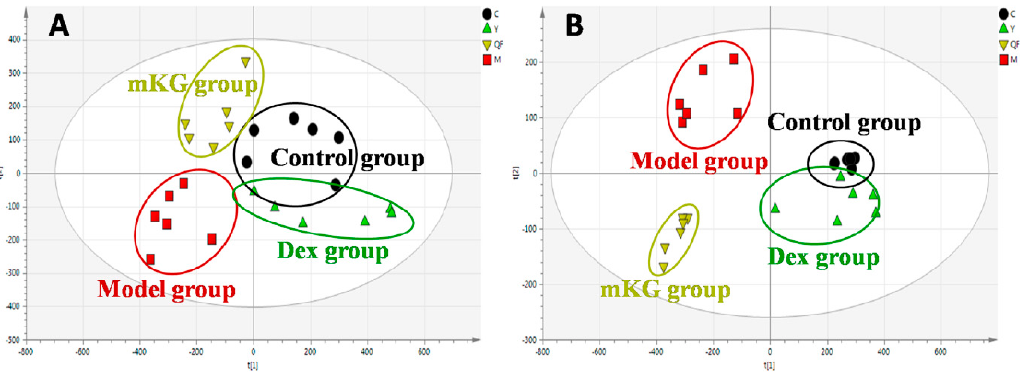
Figure 5. Score plots from the PLS − DA model classifying the control group ( ● ), model group ( ■ ), mKG group ( ▼ ), and Dex group ( ▲ ) with mice plasma samples in positive ( A ) and negative ( B ) ion modes by UPLC-Q-TOF/MS.